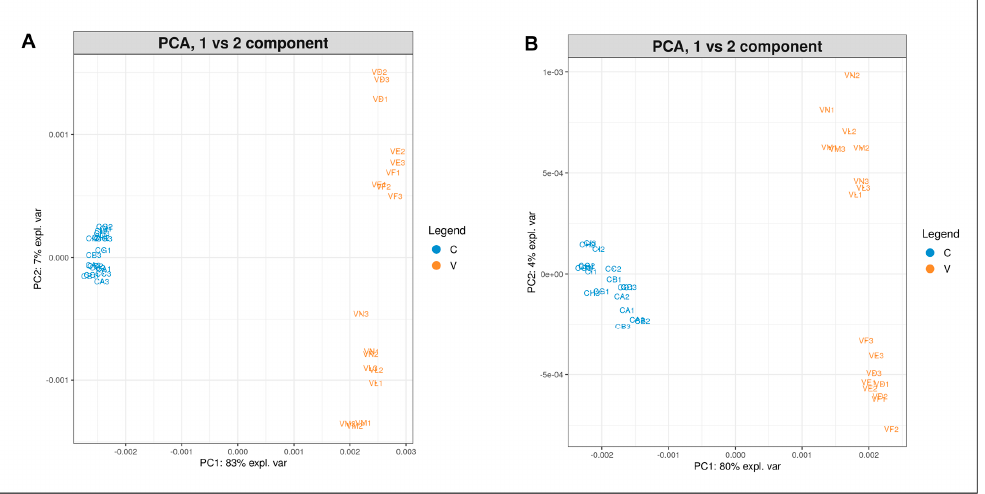
Figure 6. PCA plot (PC1 vs. PC2) of albumin ( A ) and globulin ( B ) extracts from Finola certified seeds (C, blue) and harvested seeds from the experimental field of Viganella (V, orange). Regarding Secuieni J. variety, the PCA plots (PC1 vs. PC2 component) of albumin (A) and globulin (B) protein profiles are reported in Figure 7: certified seeds formed a distinct cluster compared to seeds from the experimental field (V), which are more dispersed than the certified ones, with a total variance of 81% for albumins and 83% for globulin extracts.